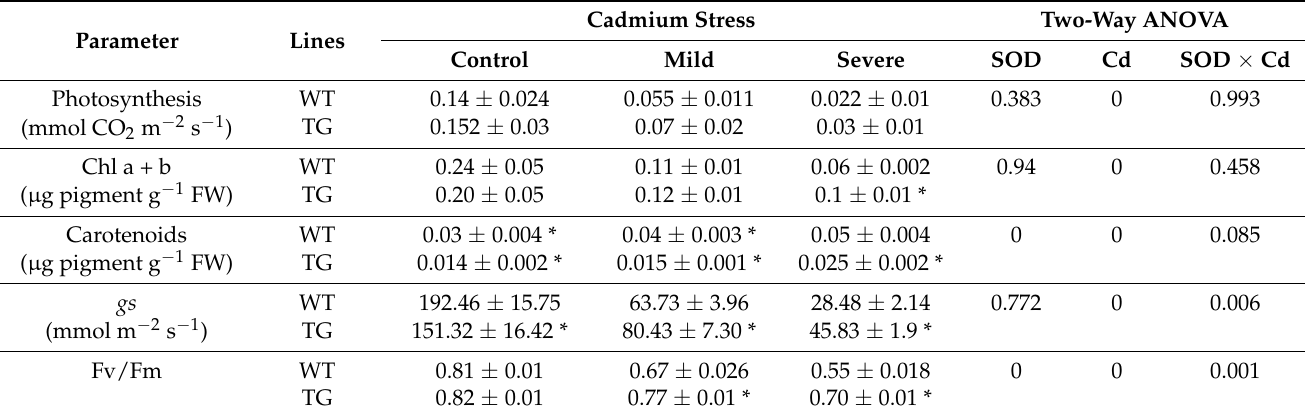
Table 2. Response of photosynthesis of the FeSOD overexpressing maize transgenic line (TG) and its wild type (WT) to cadmium stress.